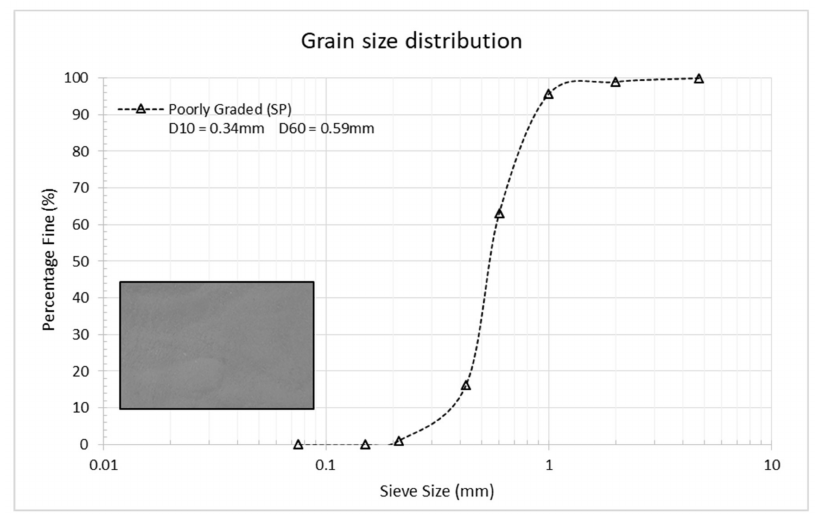
Figure 1. Particle size distribution of granular material (grey in colour) used in the present